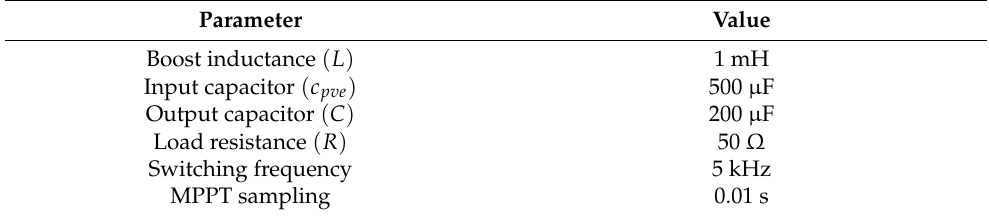
Table 1. The parameters of the PV emulation